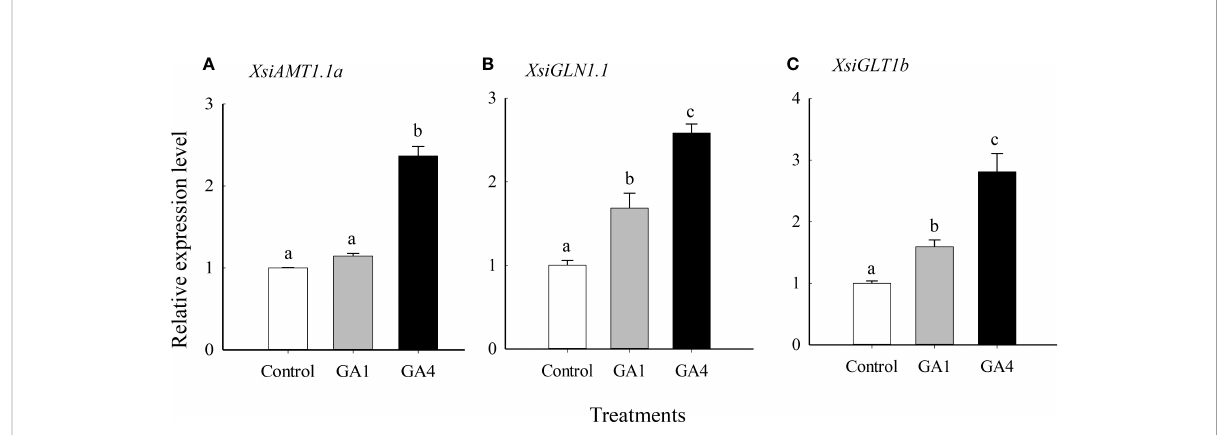
FIGURE 6 Effects of gibberellin (GA1 and GA4) on expression levels of XsiAMT1.1a (A) , XsiGLN1.1 (B) and XsiGLT1b (C) . White bars, grown in nutrient solution including 5 mmol L -1 ammonium and without GA1 and GA4 addition; gray bars, grown in nutrient solution including 5 mmol L -1 ammonium and with 1 mmol L -1 GA1 addition; black bars, grown in nutrient solution including 5 mmol L -1 ammonium and with 1 mmol L -1 GA4 addition. XsiActin1 was used as internal controls. Means + SD ( n = 3). Different letters indicate signi fi cant difference between treatments ( P < 0.05; one-way ANOVA). The names of the transcripts were based on our phylogenetic analyses (Figures